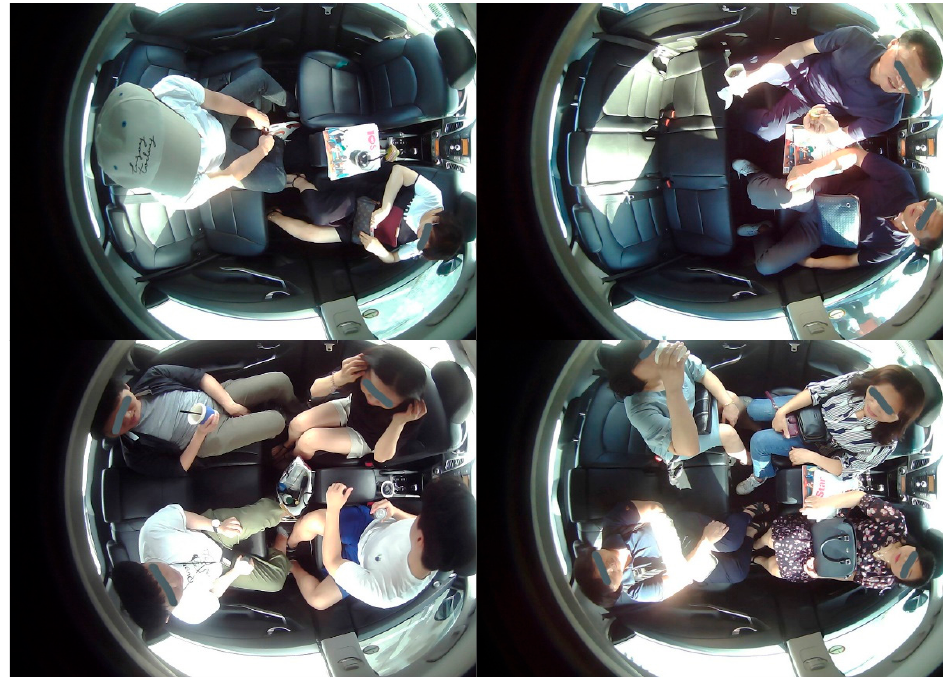
Figure 8. Few images depicting food and beverages in the cabin of a